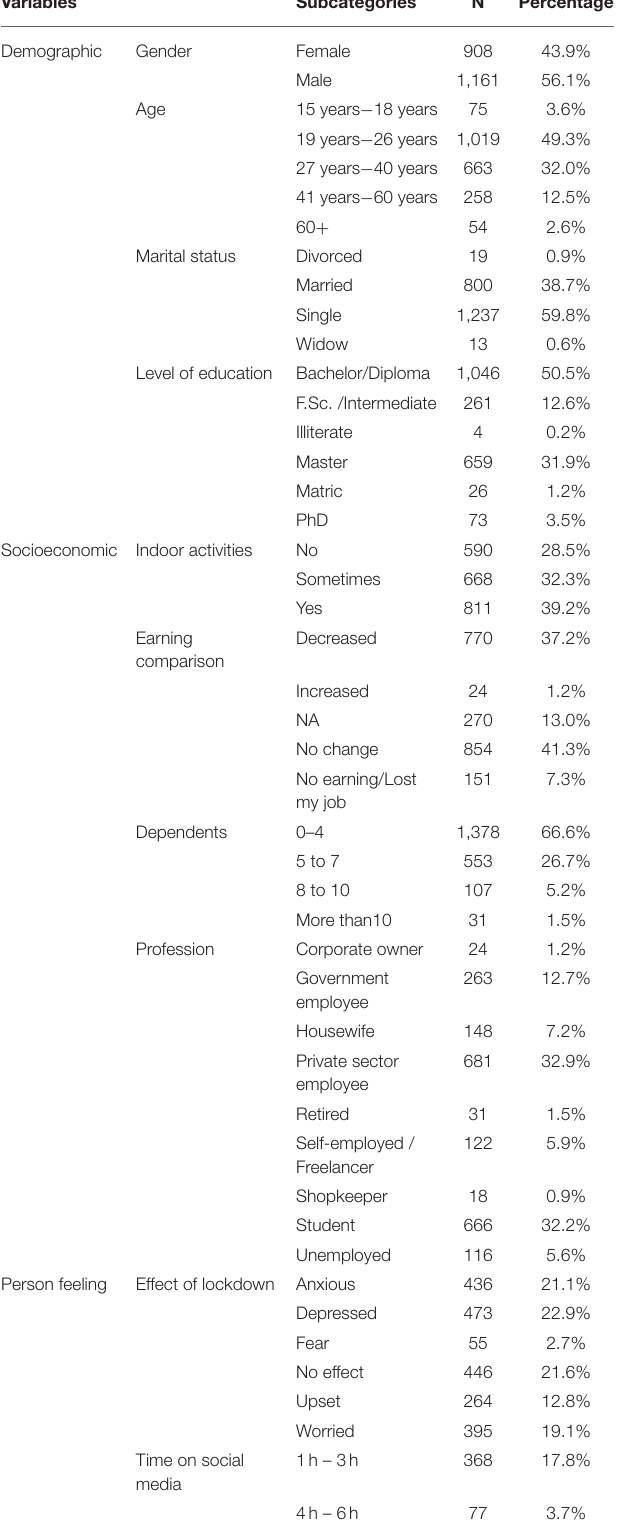
TABLE 1 | Descriptive statistics of the study population. Variables Demographic